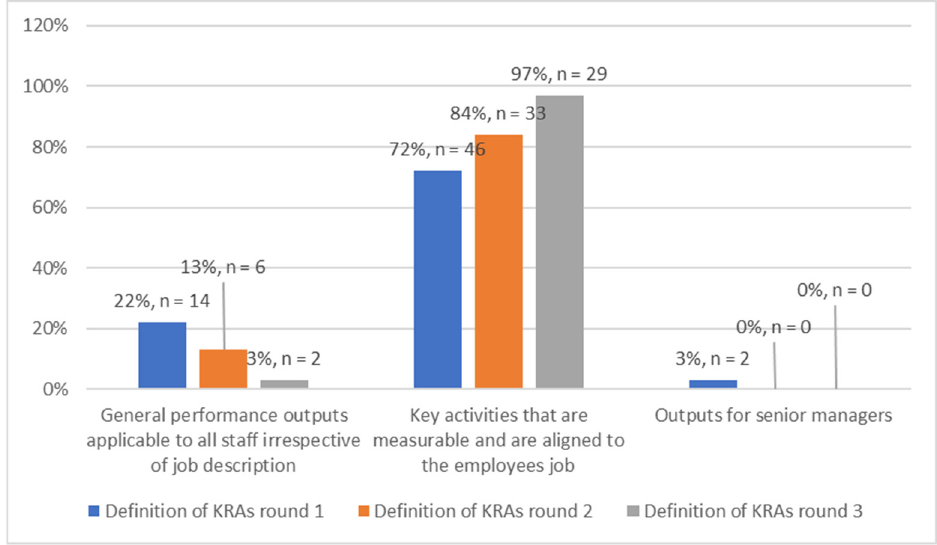
Figure 1. Definition of Key Responsibility Areas ( n = 135).